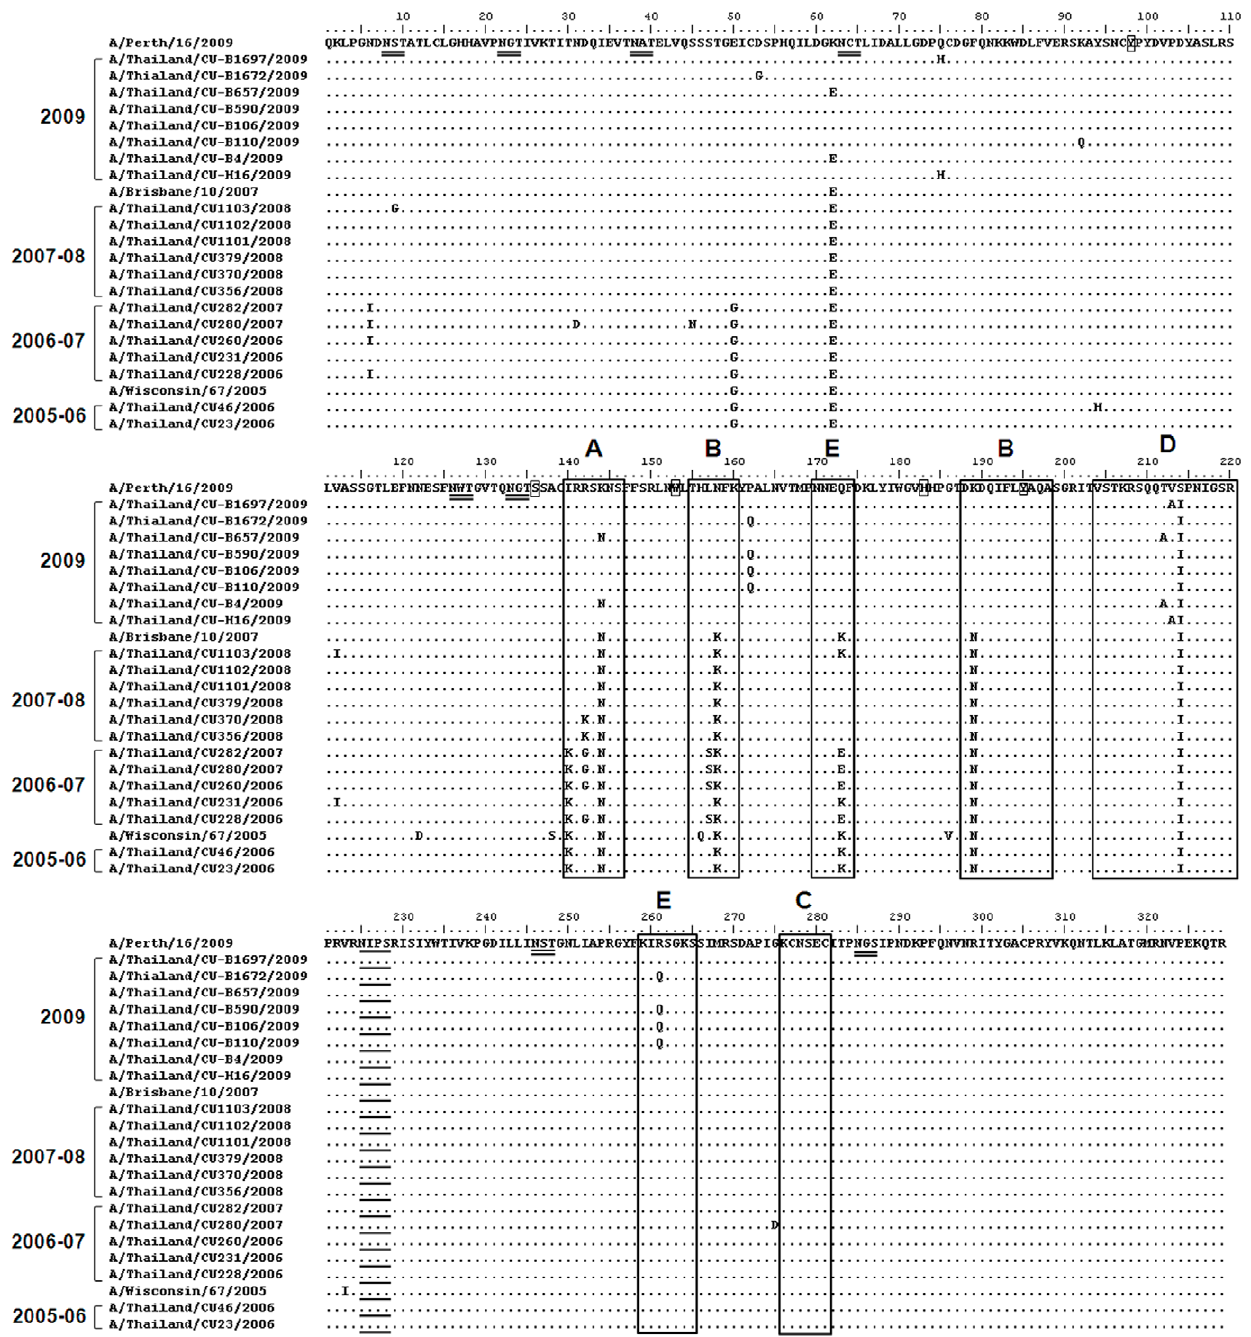
Figure 4. Amino acid comparison between HAl domains of H3N2 isolates and vaccine strains. Dots represent amino acids similar to the consensus. The conserved amino acid residues at the receptor-binding site are shown as small rectangles. Alternative amino acids for sialic acid linkages of HA are underlined. The amino acid residues mapped at previously defined antigenic sites A–E are shown as large rectangles. The the potential N-glycosylation sites, with threshold value of . 0.5, are double-underlined.